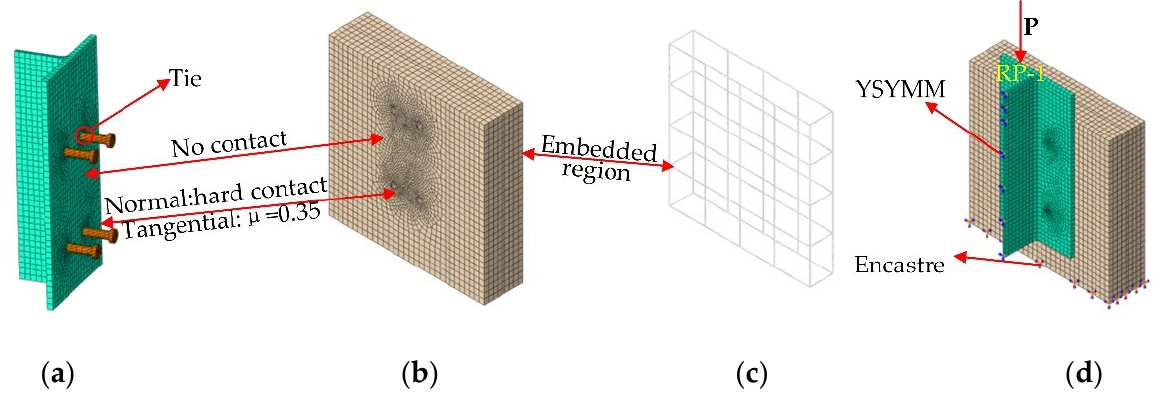
Figure 8. FE model: ( a ) steel beam and studs; ( b ) SFRCC slab; ( c ) rebar; ( d ) specimen. Table 6. Plastic damage model parameters.